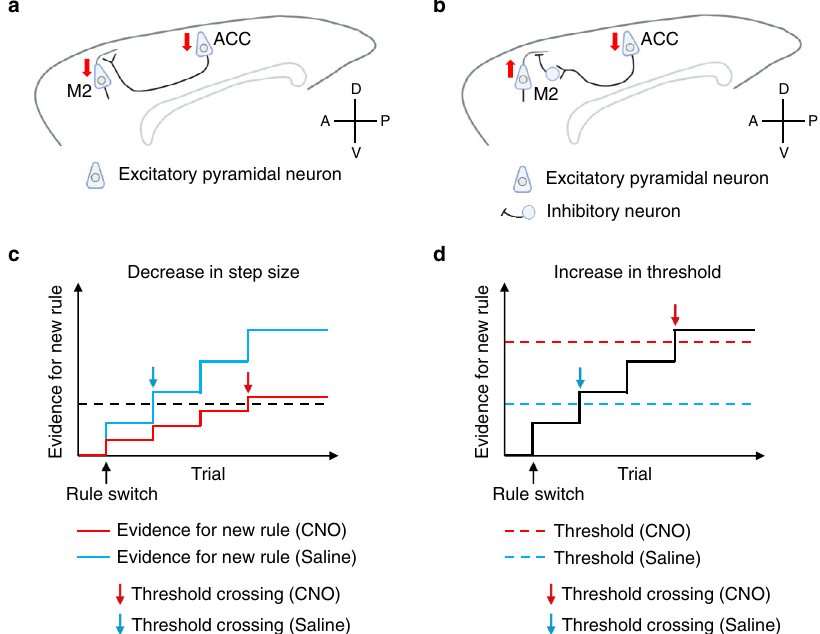
Fig. 10 |Possiblemechanismsofhowsilencing ofACCneuronsaffectsanimals ’ task-switching performanceby modulatingrulerepresentations in M2circuit. a A possible ACC-M2 circuit in which silencing of ACC neurons decreases the activity of outcome-encoding M2 neurons (positive outcome-activated neurons, positive outcome-suppressed neurons, and negative outcome-suppressed neu- rons; see Fig. 7b for their activity pro fi les).Reddown arrowindicates a decrease in activity. b A possible ACC-M2 circuit in which silencing of ACC neurons enhances theactivityofnegativeoutcome-activatedM2neurons(seeFig.7b,cforitsactivity pro fi le). In this circuit model, when ACC neurons are silenced, a disinhibition mechanism in M2 increases the activity of negative outcome-activated M2. Red upward or downward arrow indicates an increase or a decrease in activity, respectively. c An evidence accumulation model describing how silencing of ACC neurons can affect an animal ’ s rule switch performance. In this model, an animal updates the choice rule (i.e., 1 step or 2 steps rule) when the evidence for the